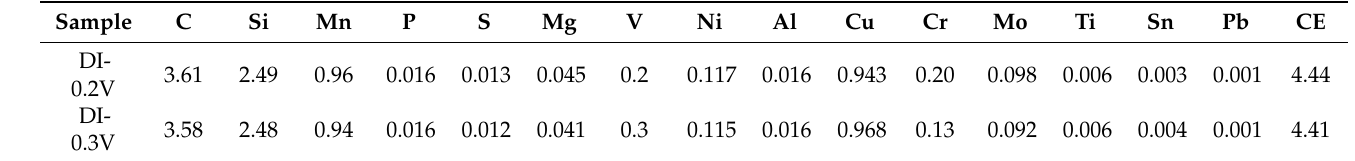
Table 2. Chemical composition of camshafts low alloyed with vanadium (wt.%).